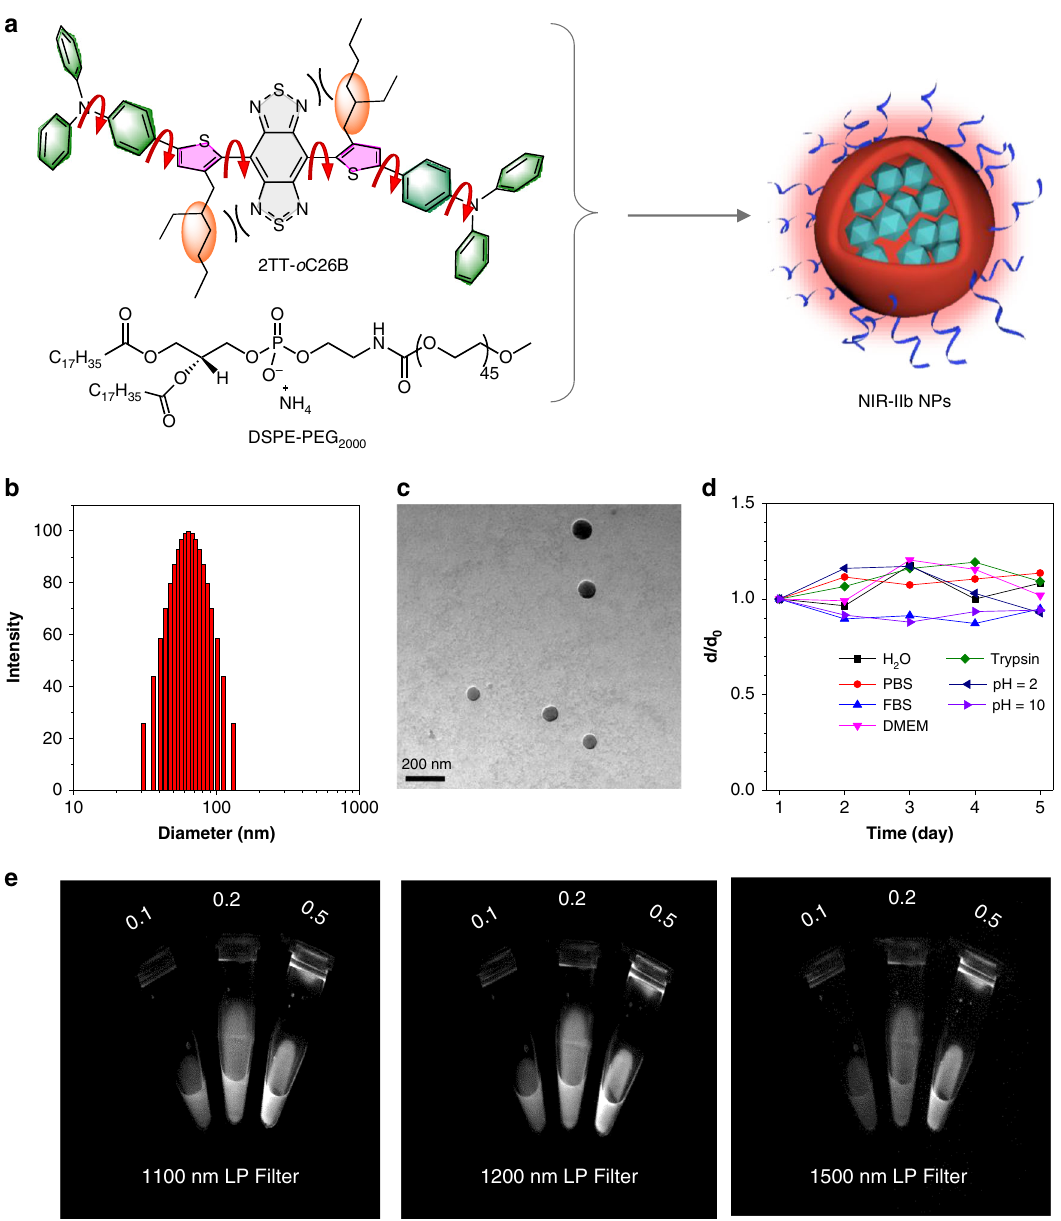
Fig. 4 Characterization of 2TT- o C26B NPs. a Schematic illustration of 2TT- o C26B NPs. b Representative DLS result and c TEM images. d Variation of diameter ratio ( d / d 0 ) of 2TT- o C26B NPs in a different medium, where d 0 was the initial diameter. e Comparison of NIR-II signals under different LP fi lters at different concentrations